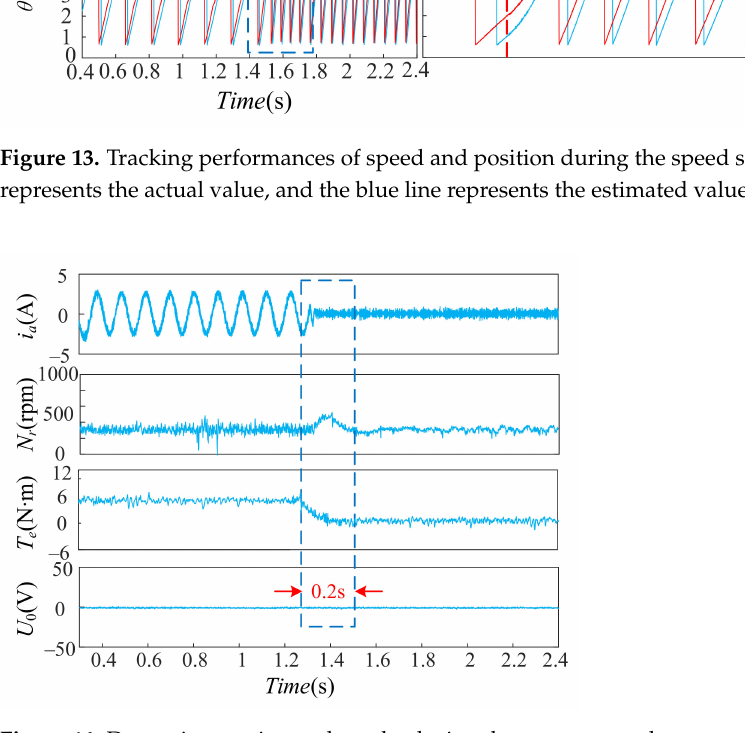
Figure 14. Dynamic experimental results during the torque